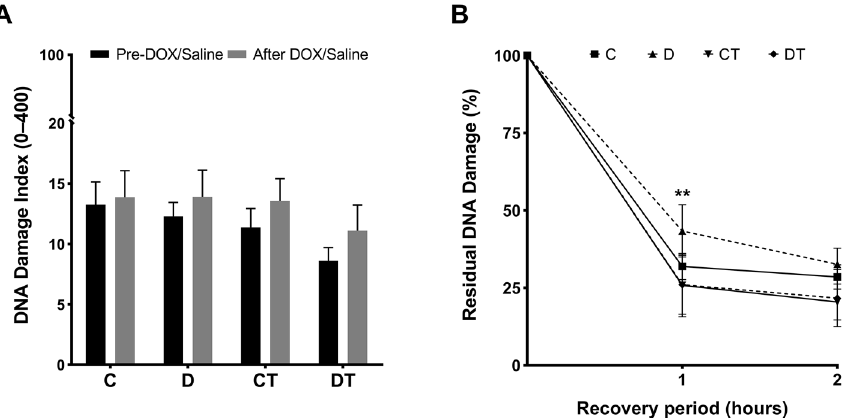
Figure 6. DNA damage and repair capacity in peripheral blood mononuclear cells of doxorubicin-treated animals. ( A ) Basal DNA damage evaluated in Comet Assay; ( B ) DNA repair capacity in blood cells after ex vivo treatment with tert-butyl hydroperoxide, followed by a repair period for 1 h or 2 h in the absence of the oxidizing agent. C: control (n = 8); D: doxorubicin-treated (n = 10); CT: control-trained (n = 8); DT: doxorubicin- trained (n = 8). Two-way ANOVA and Bonferroni’s post-hoc, standard error mean. **p < 0.01 above error bars in comparison to doxorubicin-trained group at same post-incubation